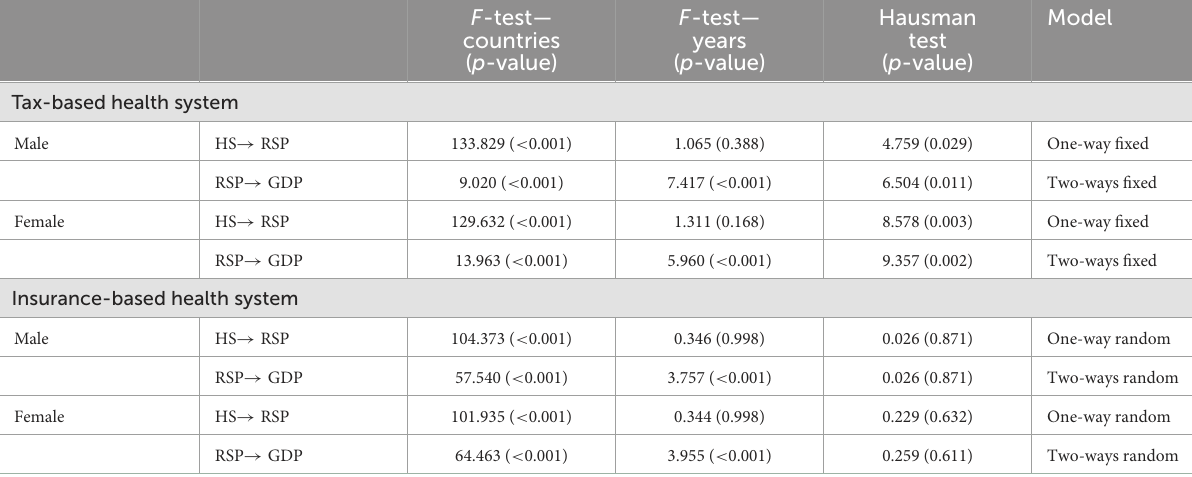
TABLE 2 Testing the assumptions for the selection of regression